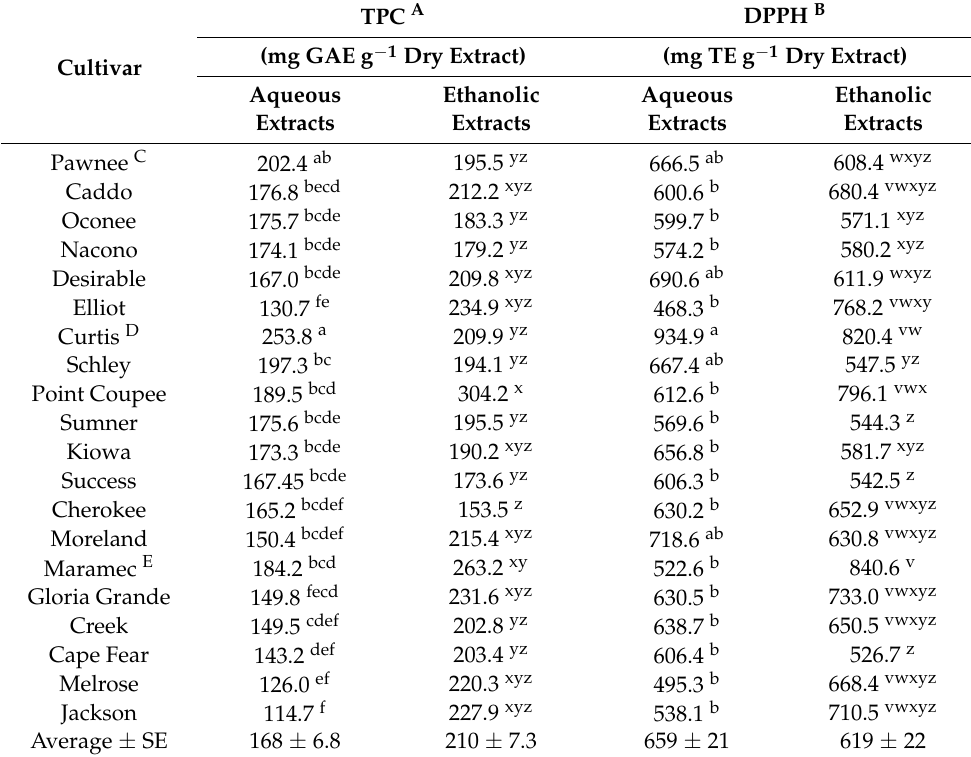
Table 2. Estimated phenolic content and antioxidant activity of shell extracts.